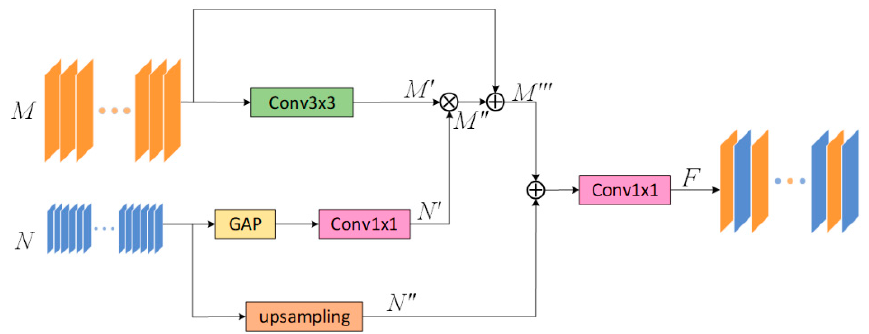
Figure 2. The design of the feedback fusion module (FFB). It improves the ability of feature reuse by performing feedback fusion on two adjacent layers. Table 1. Operation of FFB module.